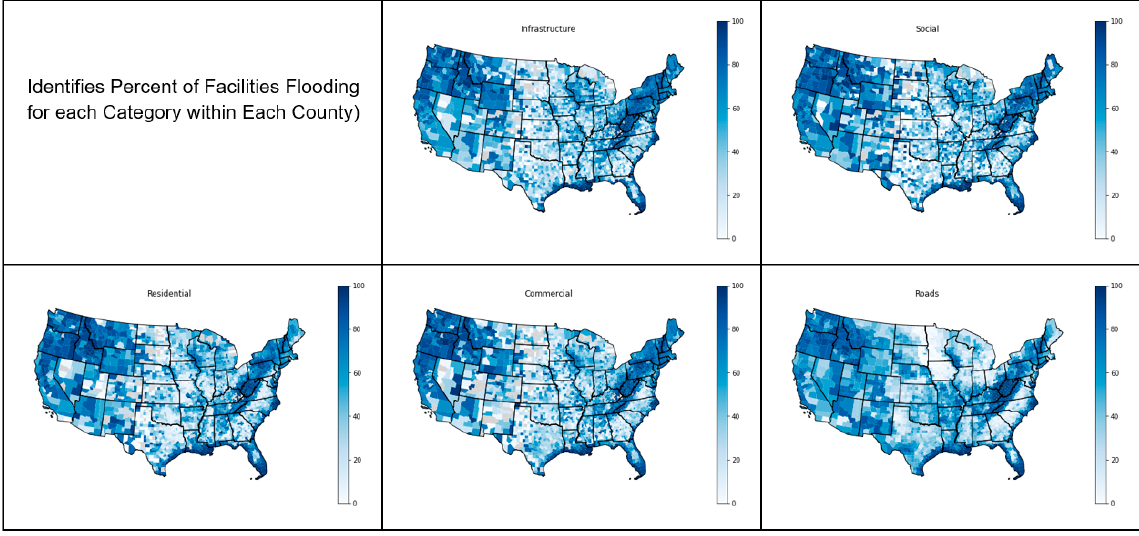
Figure 3. County comparison for each dimension (percent of infrastructure with operational risk).